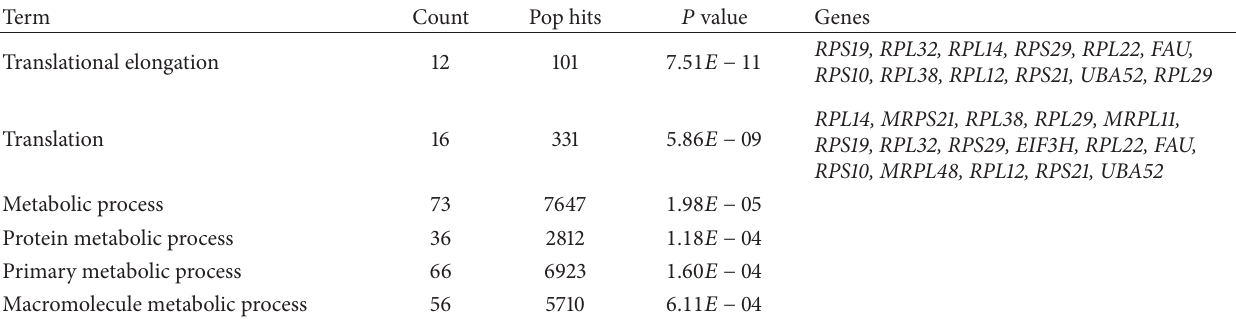
Table 2: GO enrichment of genes coexpressed with MRCs only in chemically treated